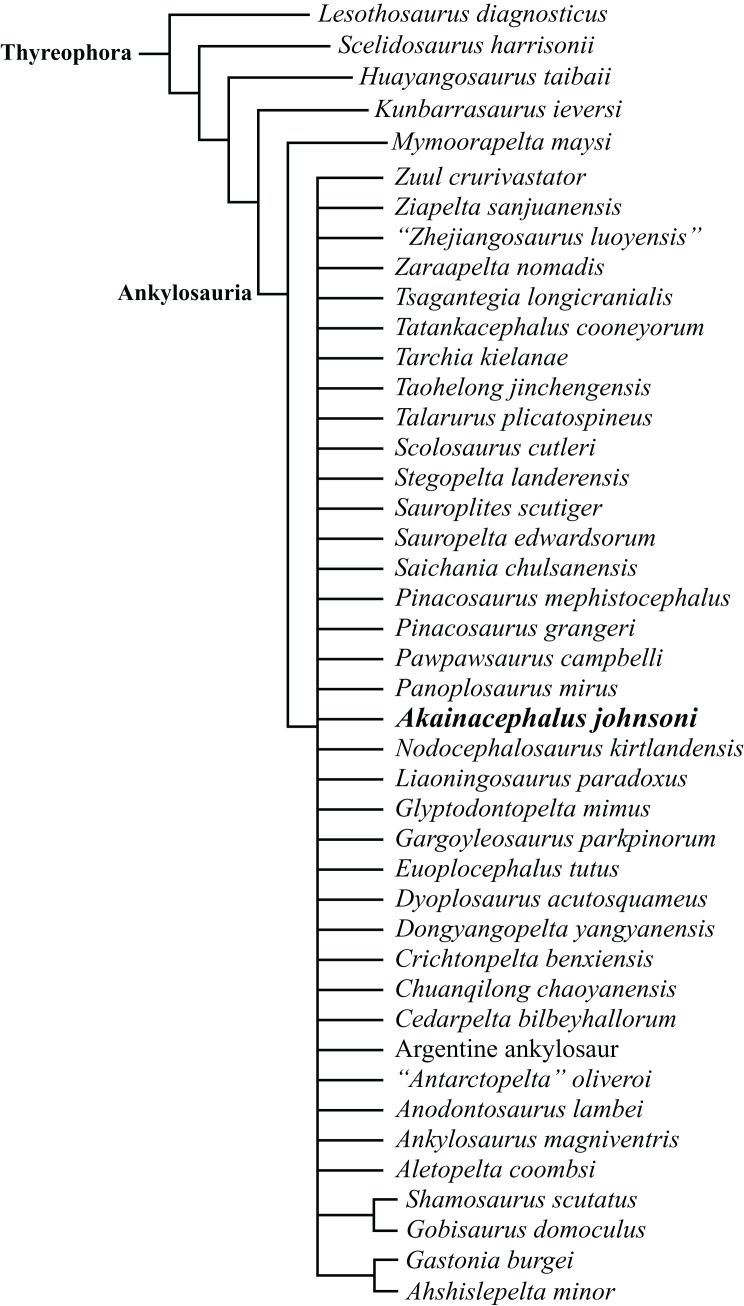
Phylogenetic results using character state codings from Arbour & Evans (2017).Phylogenetic analysis resulting in a strict consensus of 1990 equally most parsimonious trees and the phylogenetic position of Akainacephalus johnsoni, implemented into the character matrix from Arbour & Evans (2017). The resulting consensus tree renders A. johnsoni poorly resolved, consistently placing it within a large polytomy.